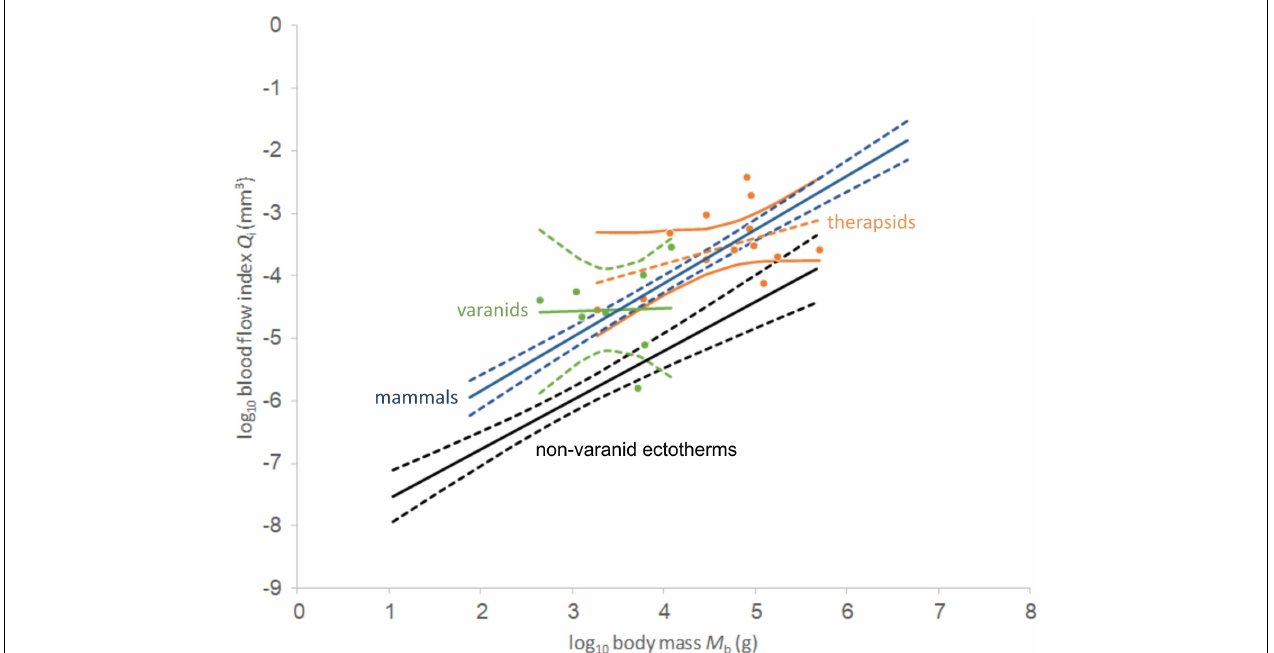
FIGURE 4 | Double-logarithmic plot and linear regression lines of blood flow index against body mass for non-mammalian therapsids (orange dots) and varanids (green dots). 95% confidence intervals of the regression mean are supplied for the plotted taxa, non-varanid ectotherms (black) and mammals (blue). Note wide range among both taxa and similar slope. Data except non-mammalian synapsids from Seymour et al. (2012).